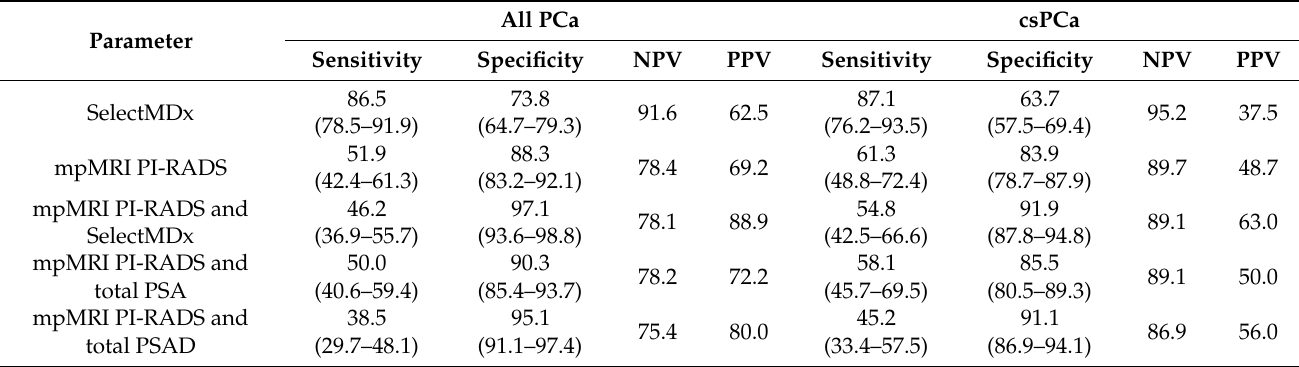
mpMRI = Multiparametric magnetic resonance imaging, PI-RADS = Prostate Imaging-Reporting and Data System, PSA = prostate-specific antigen, PSAD = PSA density, PCa = prostate cancer, csPCa = clinically significant PCa, NPV = negative predictive value, PPV = positive predictive